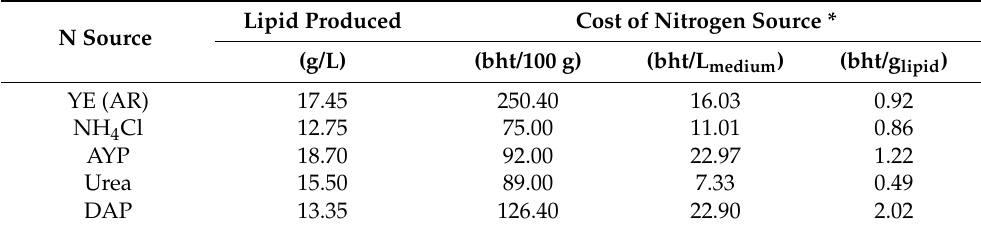
Table 8. Comparing the cost of nitrogen sources for lipid